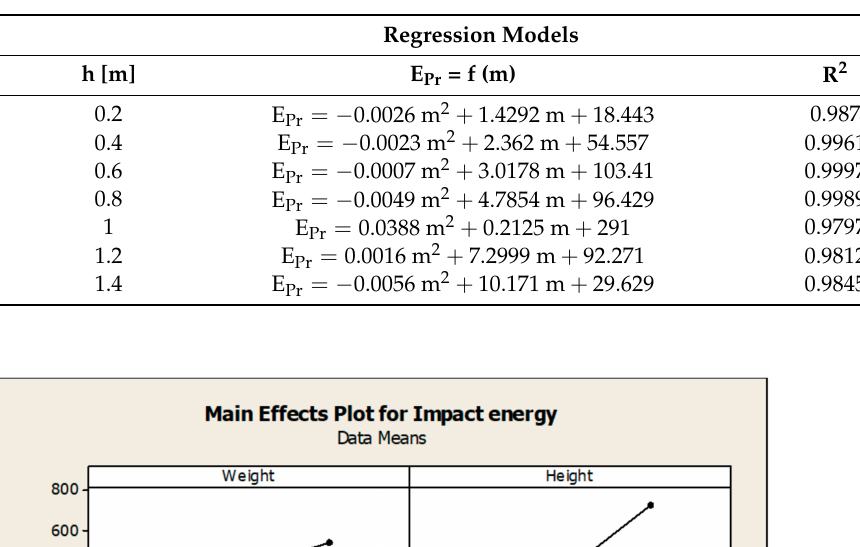
Table 6. Regression models of impact energy E Pr [J] for individual impact heights h [m] using the pyramidal impactor with hammer mass m [kg] for interval 50–100 kg.